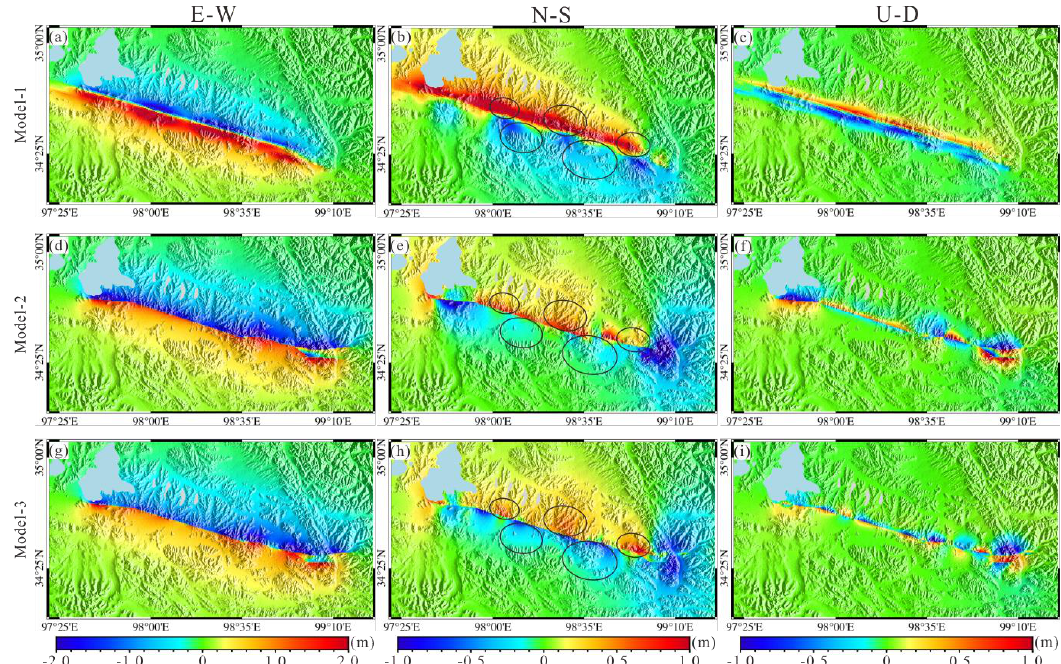
Figure 11. Synthetic 3D coseismic displacement maps from the source models are constrained by different datasets. Model–1 was modeled from the slip model of USGS ( a – c ), Model–2 was modeled from the slip model only constrained by DInSAR observations ( d – f ), Model–3 was modeled from the slip model jointly constrained by DInSAR and BOI observations ( g – i ). The three panels from left to right indicate the east–west, north–south and up–down displacement components, respectively.